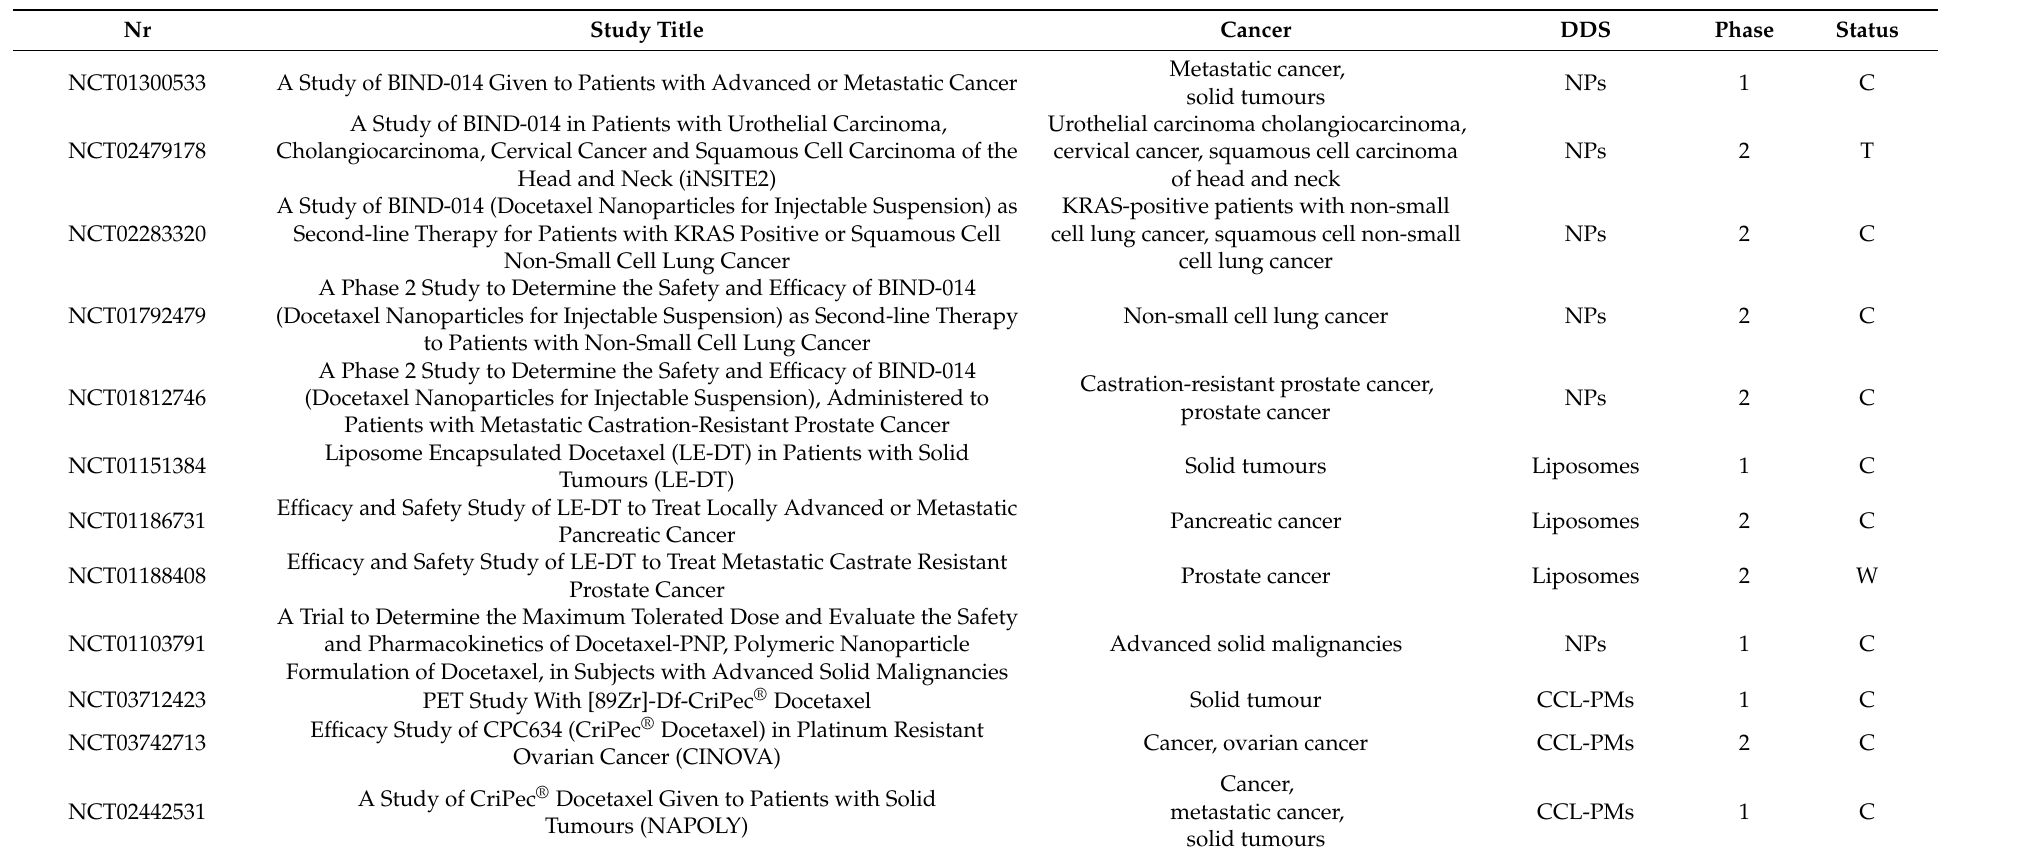
Table 2. Clinical trials of Dtx-loaded NPs based on https://clinicaltrials.gov/ (accessed on 10 February